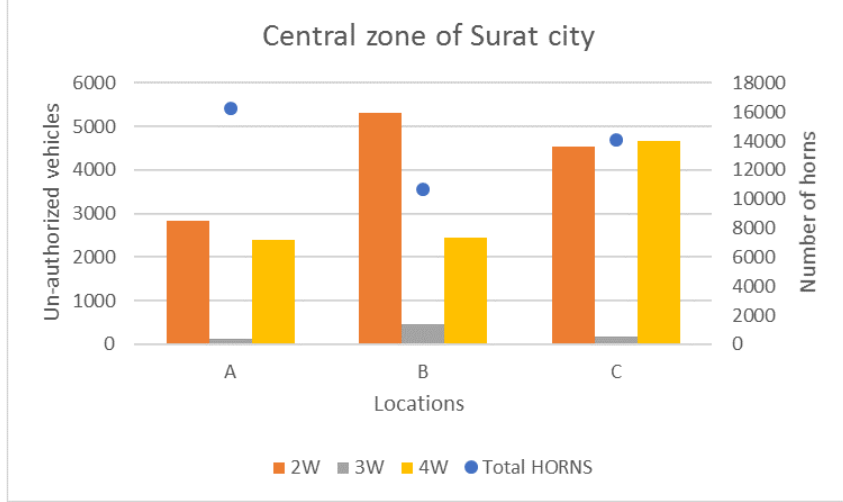
Figure 10: Correlation between un-authorized vehicles and number of horn event (Central zone of Surat city)